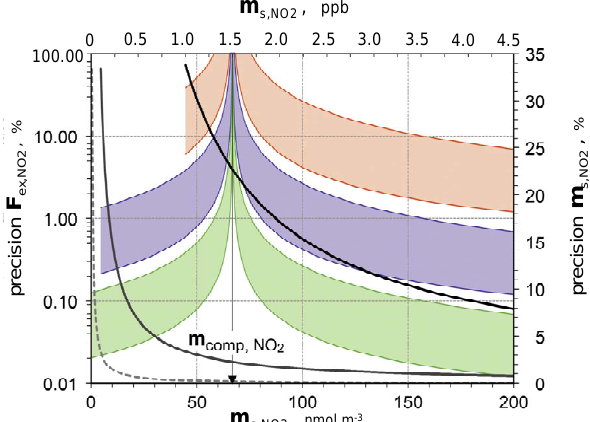
Fig. 3. The dynamic plant chamber at well defined (laboratory) Figure 3. The dynamic plant chamber at well defined (laboratory) conditions: precision of 3 conditions: precision of NO 2 concentration measurements (= NO 2 concentration measurements (= s m,s_NO2 / m s,NO2 ; right axis) and precision of derived NO 2 4 s m,s NO / m s,NO ; right axis) and precision of derived NO 2 exchange flux densities (= s Fex_NO2 / F ex,NO2 , left axis) as function of the NO 2 concentration 5 2 2 exchange flux densities (= s Fex NO / F ex,NO , left axis) as func- measured at the outlet of the dynamic chamber (precision m s,NO2 , right axis). Results are from 6 2 2 tion of the NO 2 concentration measured at the outlet of the data simulation (random number application), which considers standard errors of NO 2 7 dynamic chamber (precision m s,NO , right axis). Results are concentration measurements, and which matches pre-scribed R 2 ( m a,NO2 , m s,NO2 ) and pre-8 2 from data simulation (random number application), which con- scribed m comp,NO2 = 67 nmol m -3 (1.5 ppb). Black, grey, and dashed lines (= precision of 9 siders standard errors of NO 2 concentration measurements, m s,NO2 ) represent data for a NO 2 analyzer characterized by LOD ( m s,NO2 ) = 44.6 nmol m -3 (1.0 10 ) and pre- , m s,NO and which matches pre-scribed R 2 ( m a,NO 2 2 ppb), LOD ( m s,NO2 ) = 4.5 nmol m -3 (0.1 ppb), and LOD ( m s,NO2 ) = 0.4 nmol m -3 (0.01 ppb), 11 =67nmolm − 3 (1.5ppb). Black, grey, and scribed m comp,NO respectively. Ranges of the precision of derived NO 2 exchange flux densities are identified by 12 2 dashed lines (=precision of m s,NO ) represent data for a NO 2 reddish, bluish, and greenish areas for LOD ( m s,NO2 ) = 44.6 nmol m -3 (1.0 ppb), LOD ( m s,NO2 ) = 13 2 analyzer characterized by LOD( m s,NO )=44.6nmolm − 3 4.5 nmol m -3 (0.1 ppb), and LOD ( m s,NO2 ) = 0.4 nmol m -3 (0.01 ppb). The width of the colored 14 2 )=4.5nmolm − 3 (0.1ppb), and (1.0ppb), LOD( m s,NO areas stands for all considered combinations of R 2 and v dep,NO2 (0.99  R 2  0.9 and 15 2 )=0.4nmolm − 3 (0.01ppb), respectively. Ranges of LOD( m s,NO 0.3  v dep,NO2  0.6 mm s -1 ). The respective upper boundary of each colored area represents the 16 2 the precision of derived NO 2 exchange flux den- combination v dep,NO2 = 0.3 mm s -1 and R 2 = 0.9, while the lower boundary represents v dep,NO2 = 17 sities are identified by reddish, bluish, and green- 0.6 mm s -1 and R 2 = 0.99. 18 )=44.6nmolm − 3 (1.0ppb), ish areas for LOD( m s,NO 2 LOD( m s,NO )=4.5nmolm − 3 (0.1 ppb), and LOD( m s,NO )=0.4 2 2 nmolm − 3 (0.01ppb). The width of the colored areas stands for (0.99 ≤ R 2 ≤ 0.9 all considered combinations of R 2 and v dep,NO 2 ≤ 0.6mms − 1 ). The respective upper and 0.3 ≤ v dep,NO 2 boundary of each colored area represents the combination v dep,NO =0.3mms − 1 and R 2 =0.9, while the lower boundary 2 represents v dep,NO =0.6mms − 1 and R 2 2